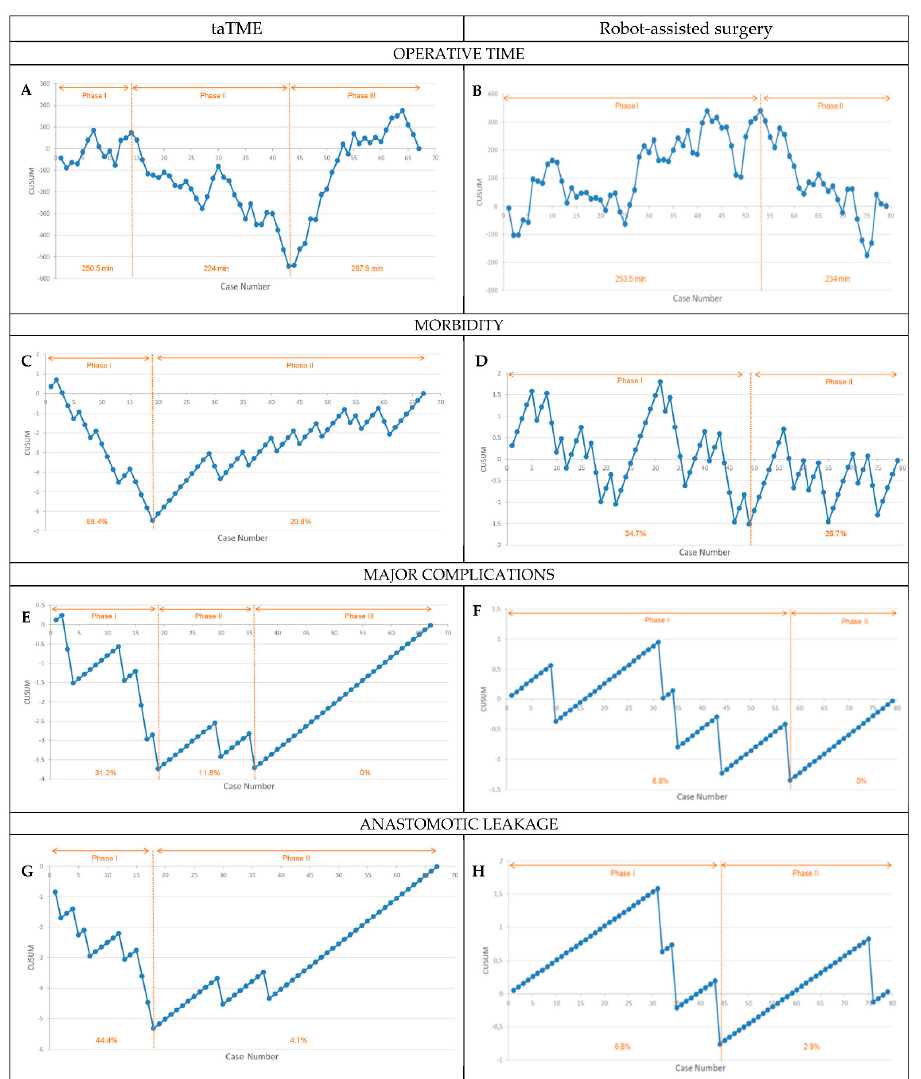
Figure 2. CUSUM learning curves for taTME and robot ‐ assisted surgery. ( A ) taTME operative time; ( B ) Robot ‐ assisted surgery operative time; ( C ) taTME morbidity; ( D ) Robot ‐ assisted surgery morbidity; ( E ) taTME major complications; ( F ) Robot ‐ assisted surgery major complications; ( G ) taTME anastomotic leakage; ( H ) Robot ‐ assisted surgery anastomotic leakage.